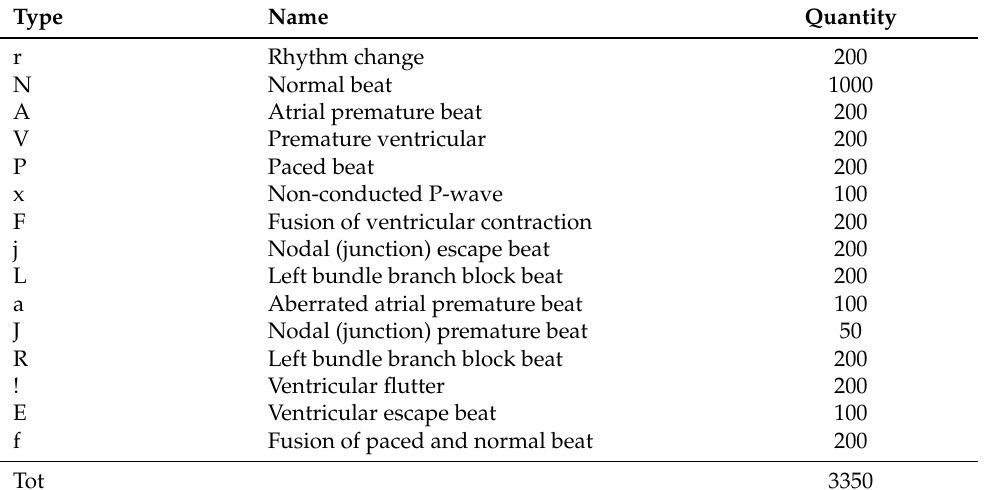
Table 1. Details of the categories for MIT-BIH database.